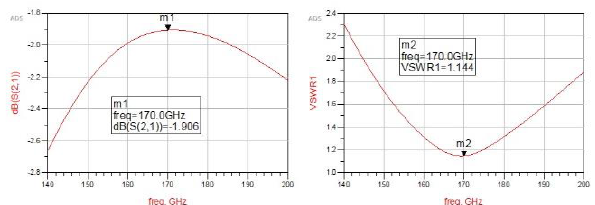
Figure 8: Simulation result of matching circuit when load impedance is set to 33.5-j*101.9Ω